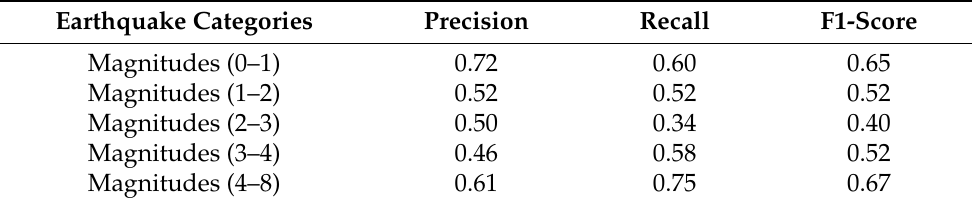
Table 2. Multi-class: Accuracy results for the proposed method in the reference paper [33]. Earthquake